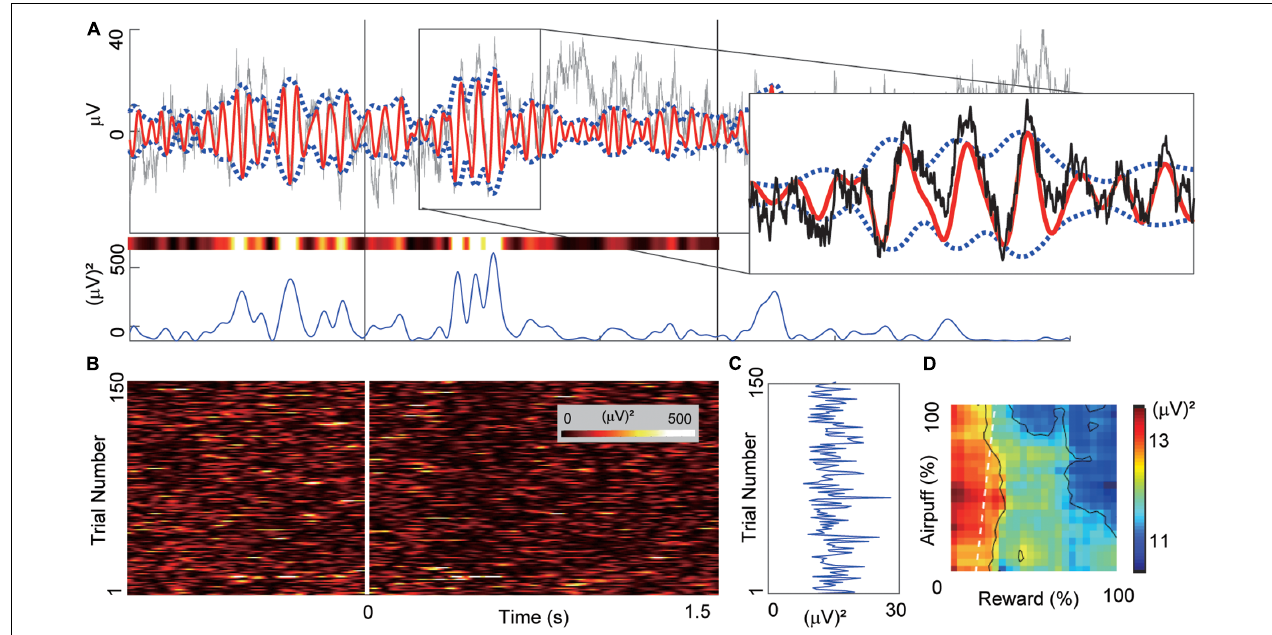
FIGURE 2 | Example of beta oscillation recorded from a CN electrode. (A) Example of the LFP activity recorded from a CN electrode aligned to the onset of the cue period. The time scale is the same as in (B) . Gray and red lines in the top panel indicate the LFP activity and the band-pass-filtered (13–28 Hz) activity. We derived the power magnitude using the difference between the upper and lower envelopes that were represented by blue dotted lines. The right inset shows a magnified view of the region inside the rectangle. The bottom panel shows the power magnitude of the envelopes. The variously colored bar above the power trace shows the same power data color-coded using the same color scale as in (B) . (B) The trial-by-trial power magnitudes as a pseudo-colored raster plot (inset shows color scale). The x -axis indicates the time from the cue onset. Y -axis indicates the trial number. (C) The mean power of the beta magnitudes averaged over the 1.5-s cue period. (D) The beta response that was produced by mapping the cue-period mean power onto the decision matrix. The mapped data were spatially smoothed by a 20%-by-20% square window. X -axis and Y -axis indicate the offered sizes of reward and punishment, respectively.